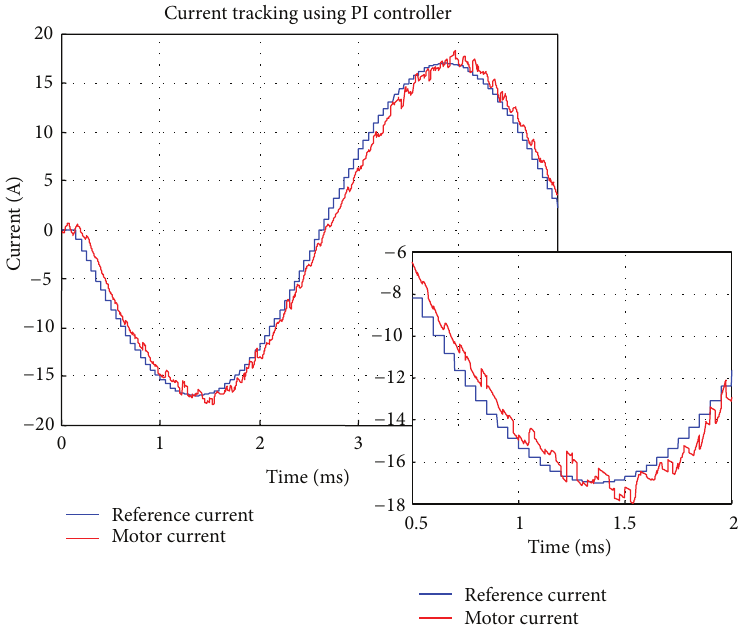
Figure 13: Current tracking obtained with the control scheme of Figure 12.